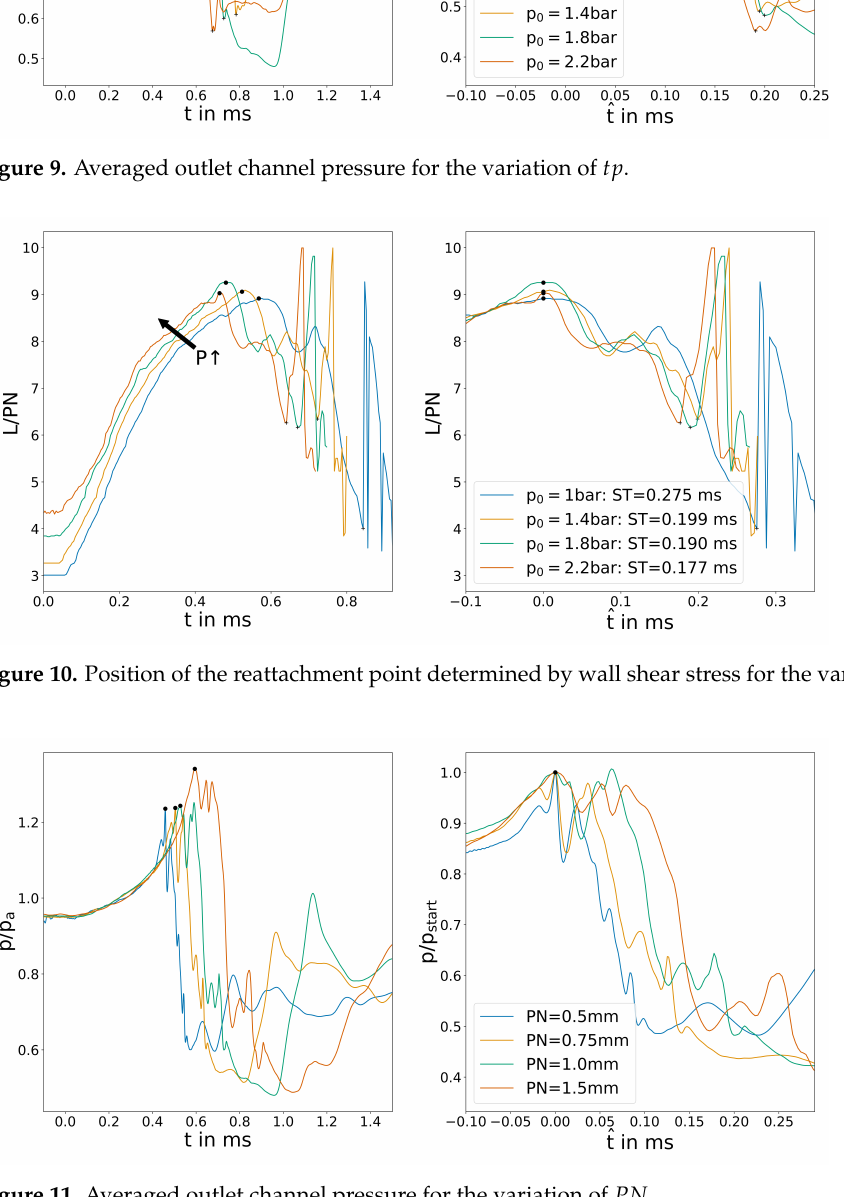
Figure 11. Averaged outlet channel pressure for the variation of PN